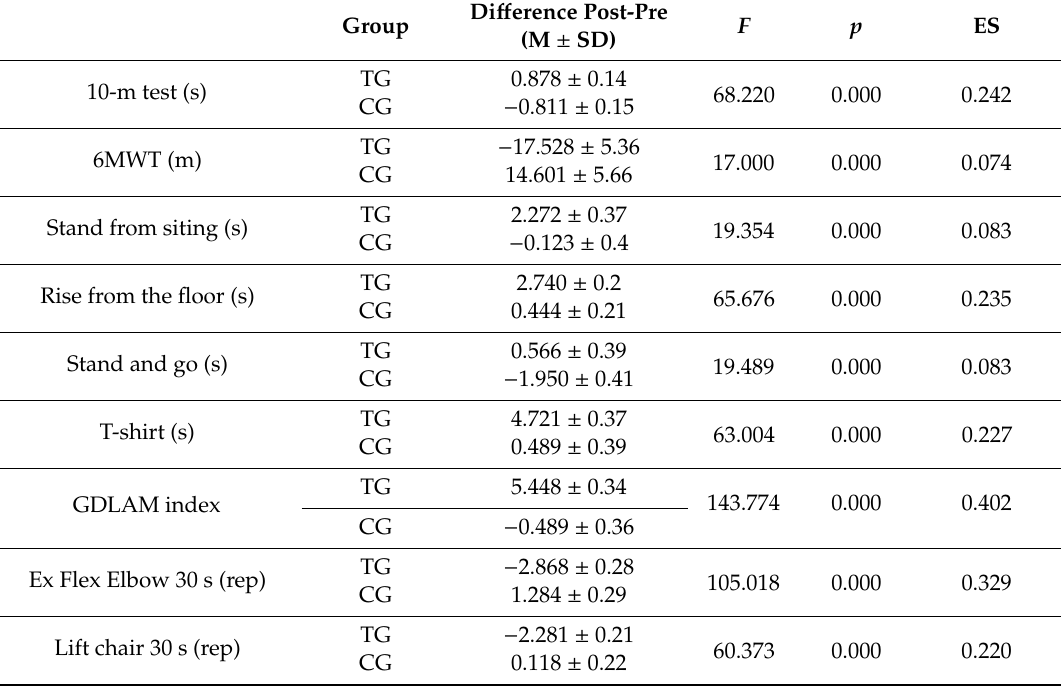
Table 4. Di ff erences pre to post-test (intergroups) for functional and fitness